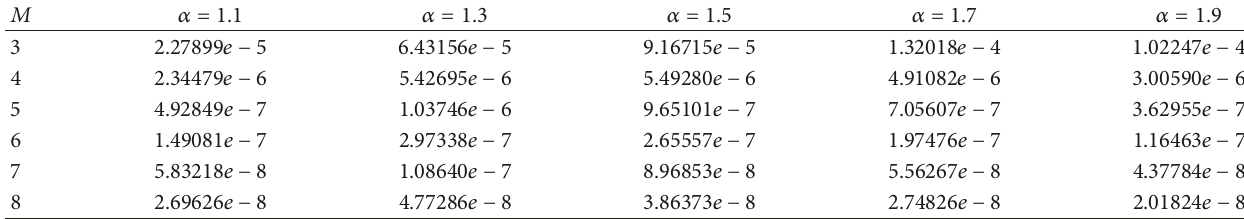
Table 9: Maximum absolute error for Example 4 with various choices of 𝑀 and 𝛼 .